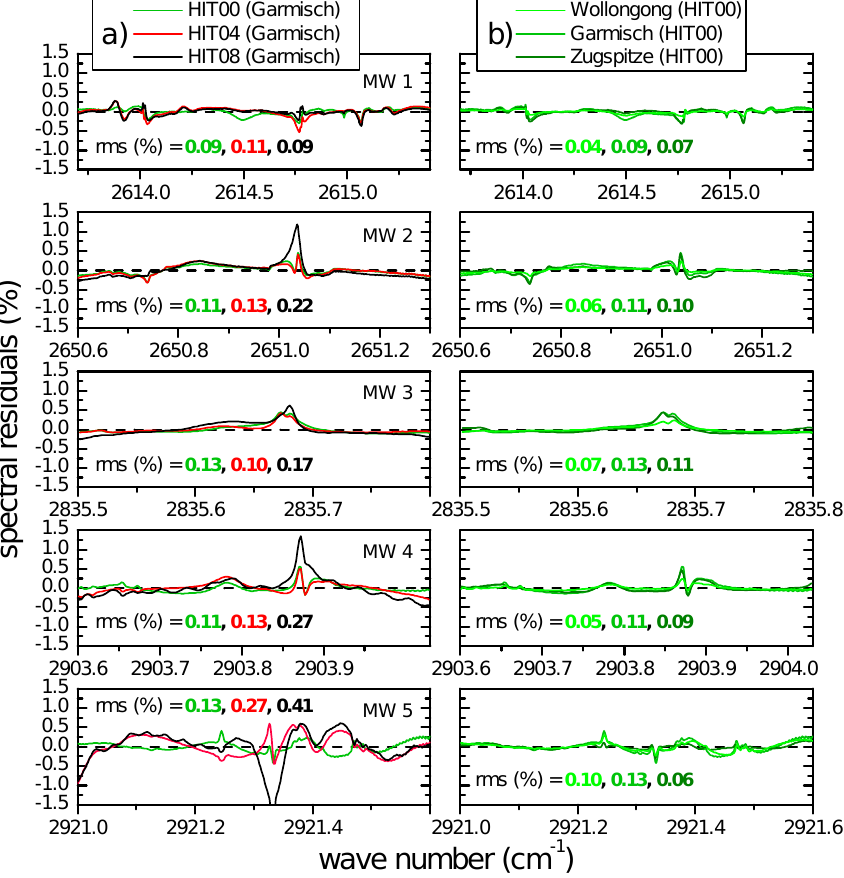
Fig. 2. (a) Averaged residuals (measured minus calculated) for the station Garmisch using HITRAN 2000 versus HITRAN 2004, and HITRAN 2008. (b) Averaged residuals using HITRAN 2000 shown for the 3 different stations Wollongong, Garmisch, and Zugspitze.